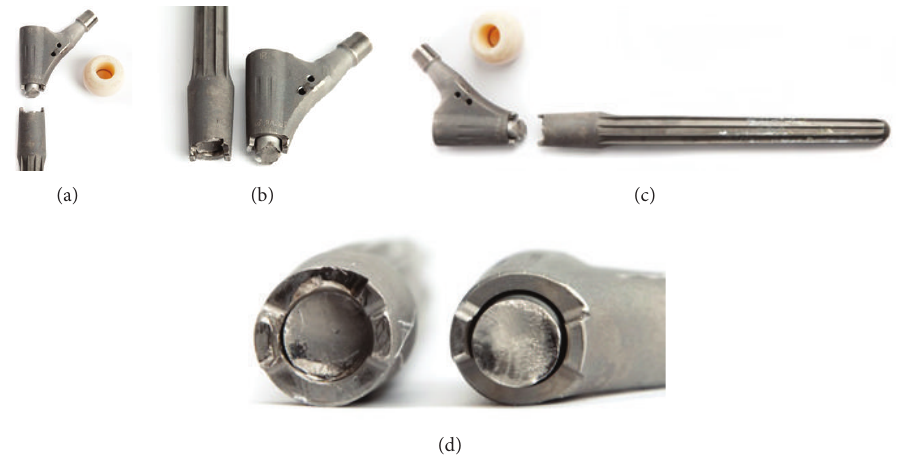
Figure 5: Photographs of retrieved Revitan